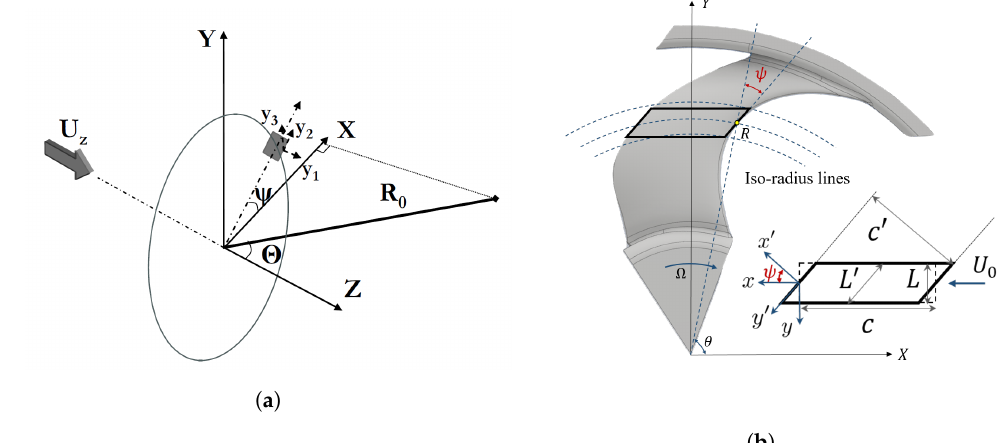
Figure 6. ( a ) From [15], the rotating local airfoil reference frame is denoted. The fixed reference frame x = ( X , Y , Z ) defines the observer’s position. ( b ) Sweep-angle definition over the leading edge of the fan blade; the rotated local reference frame ( x (cid:48) , y (cid:48) , z ) is